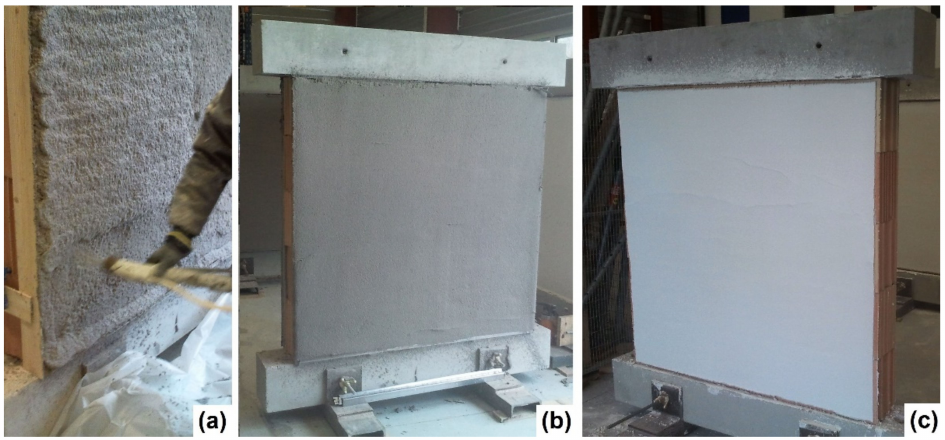
Figure 1. ( a ) Applying the second ISO layer on the masonry specimen; ( b ) masonry with ISO coating; ( c ) masonry with MGF